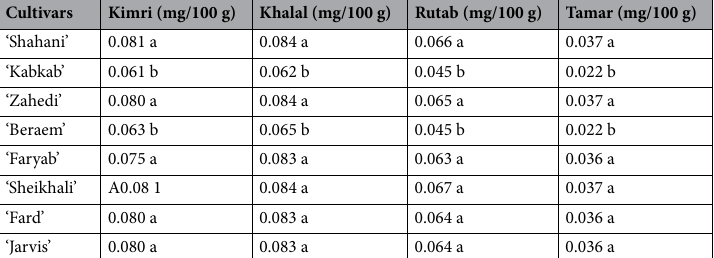
Table 7. The amount of anthocyanin in ‘Piarom’ date fruit in kimri, khalal, rutab and tamar stages after pollination with eight pollinating cultivars. Different letters within columns indicate significant differences according to Duncan’s multiple range test (p < 0.05).